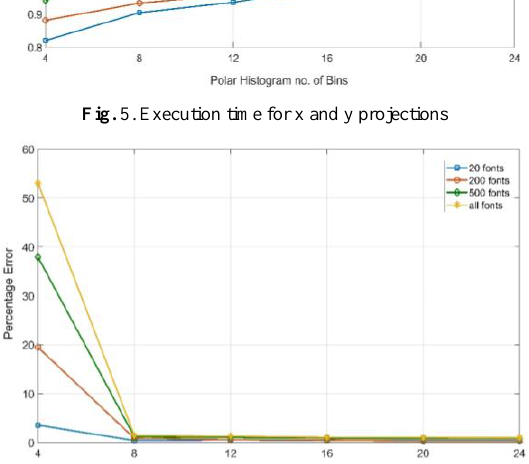
Fig. 6. Error for various font choices for all bins